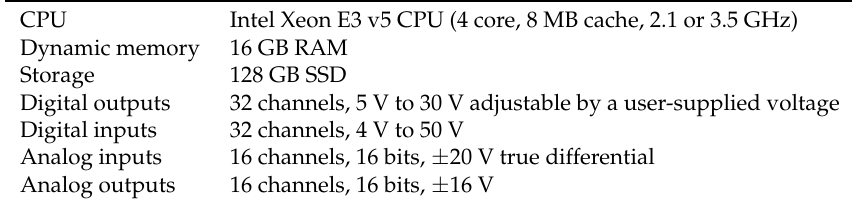
Table 2. Technical specifications of the OP4510 real-time digital